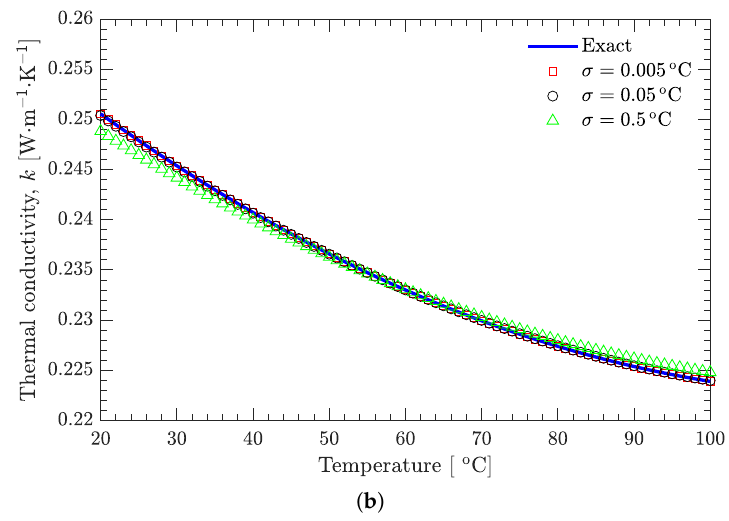
Figure 6. Effect of random noise on the recovered temperatures and on the estimated thermal conductivity; a quadratic function of k ( T ) is prespecified. ( a ) Temperature. ( b ) Thermal conductivity.